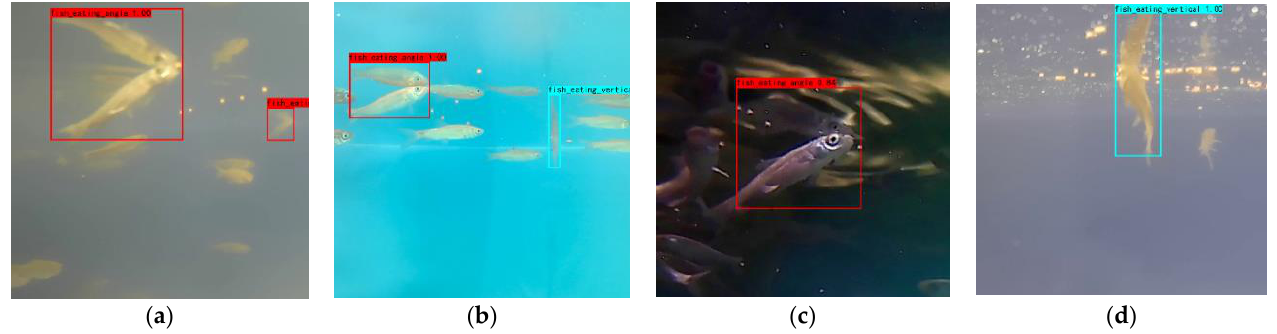
Figure 15. Network detection results under different conditions: ( a ) network detection results under sunny conditions; ( b ) network detection results under cloudy conditions; ( c ) network detection results under dark conditions; ( d ) network detection results under bubble conditions.